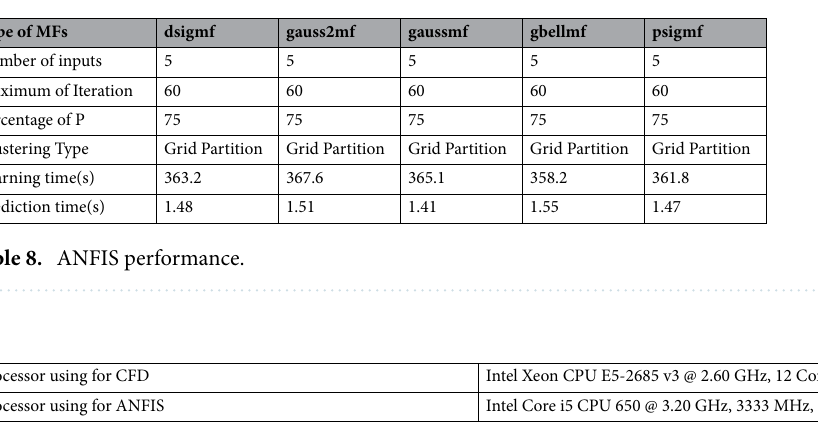
Table 9. Computer configuration for ANFIS and